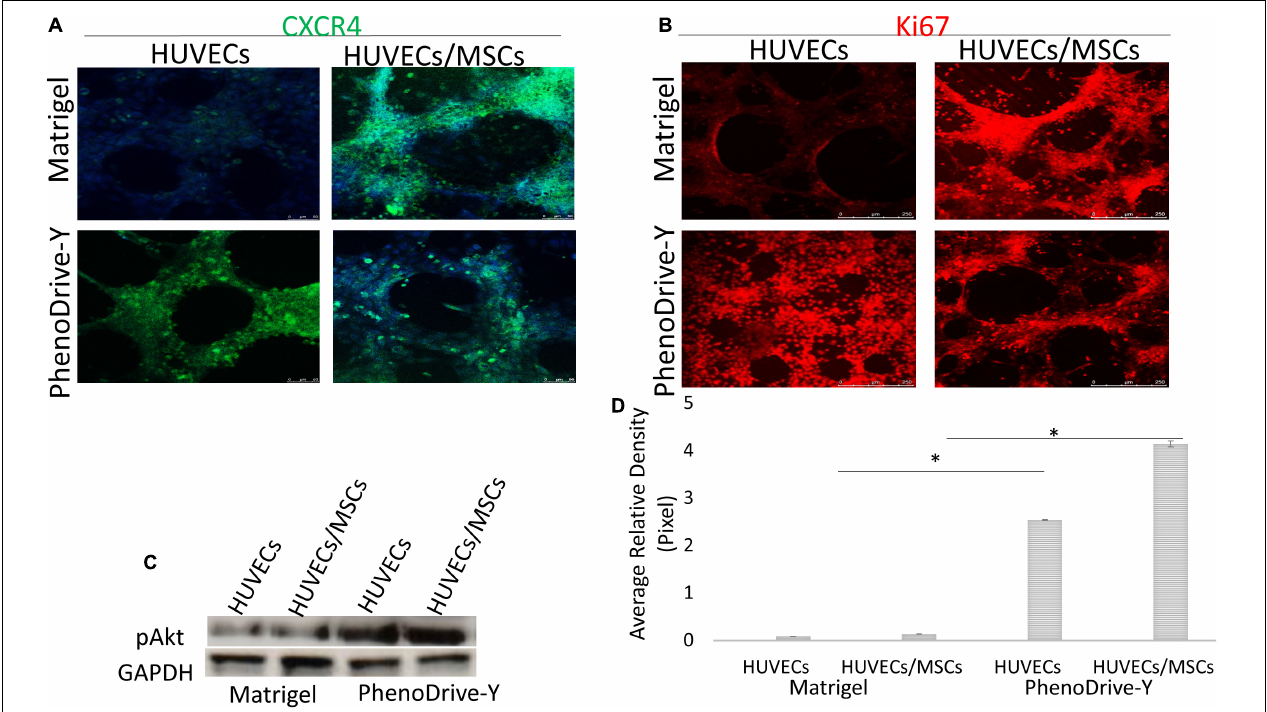
FIGURE 6 | (A,B) Localization of markers for CXCR4 ( green ) (A) and Ki67 ( red ) (B) compared to DAPI nuclear staining ( blue ). Scale bar , 50 µ m. (C,D) pAkt regulation within the monocultured and co-cultured human umbilical vascular endothelial cells (HUVECs) on both matrices at 48 h (C) and its quantification (D) . * p ≤ 0.01.